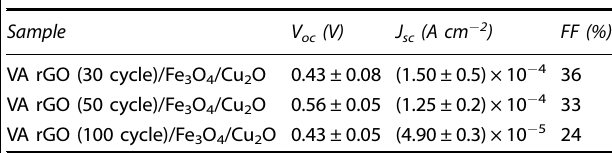
Table 1. Photovoltaic